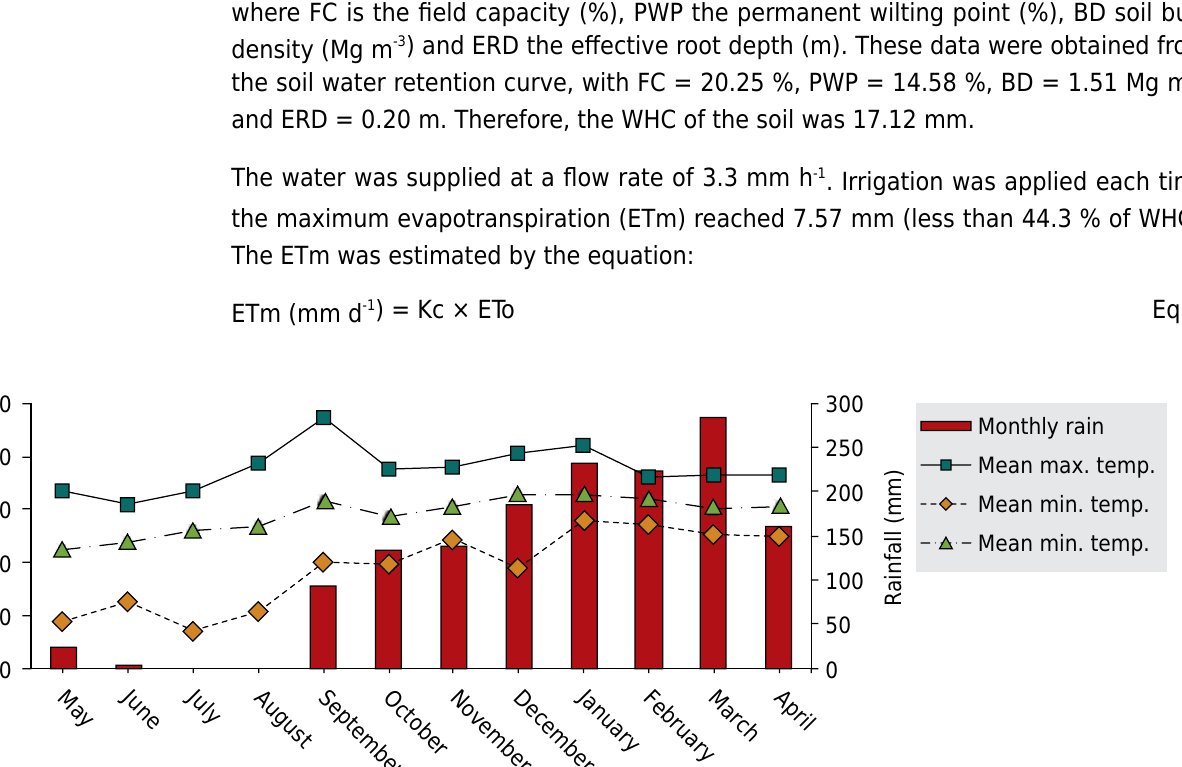
Figure 1. Mean rainfall values, maximum, minimum and mean temperature from May 2010 to April 2011, in Selvíria, Mato Grosso do Sul. Source: Laboratório de Hidráulica e Irrigação, Faculdade de Engenharia (FE/UNESP), Campus de Ilha Solteira,